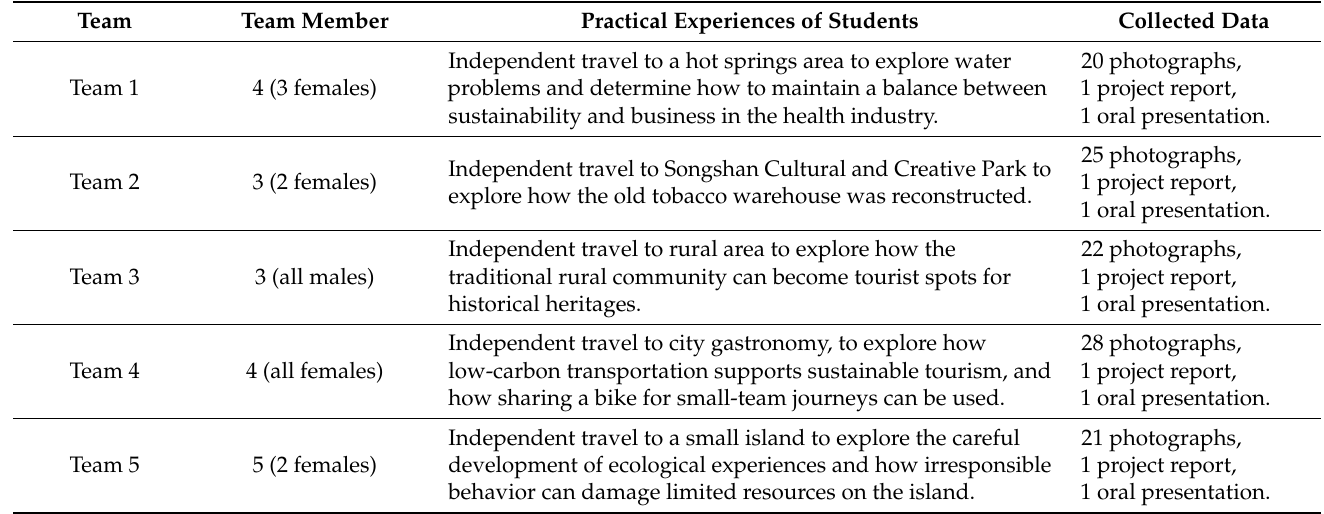
Table 1. Data collection from practical experiences of students during